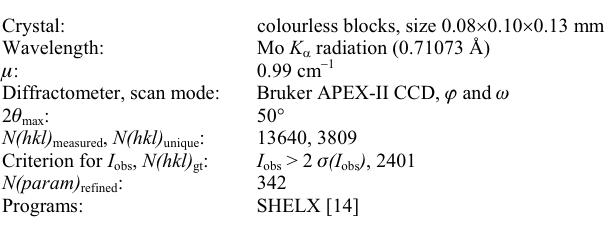
Table 1. Data collection and handling.